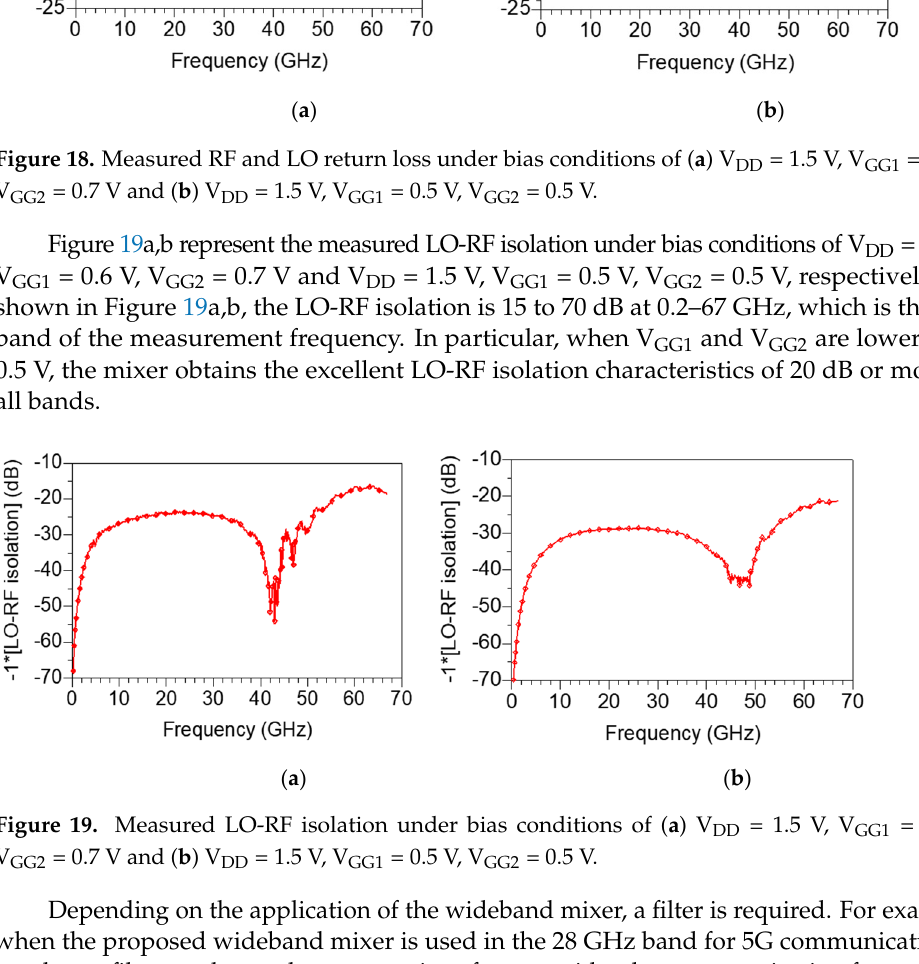
Figure 19. Measured LO-RF isolation under bias conditions of ( a ) V DD = 1.5 V, V GG1 = 0.6 V, V GG2 = 0.7 V and ( b ) V DD = 1.5 V, V GG1 = 0.5 V, V GG2 = 0.5 V.